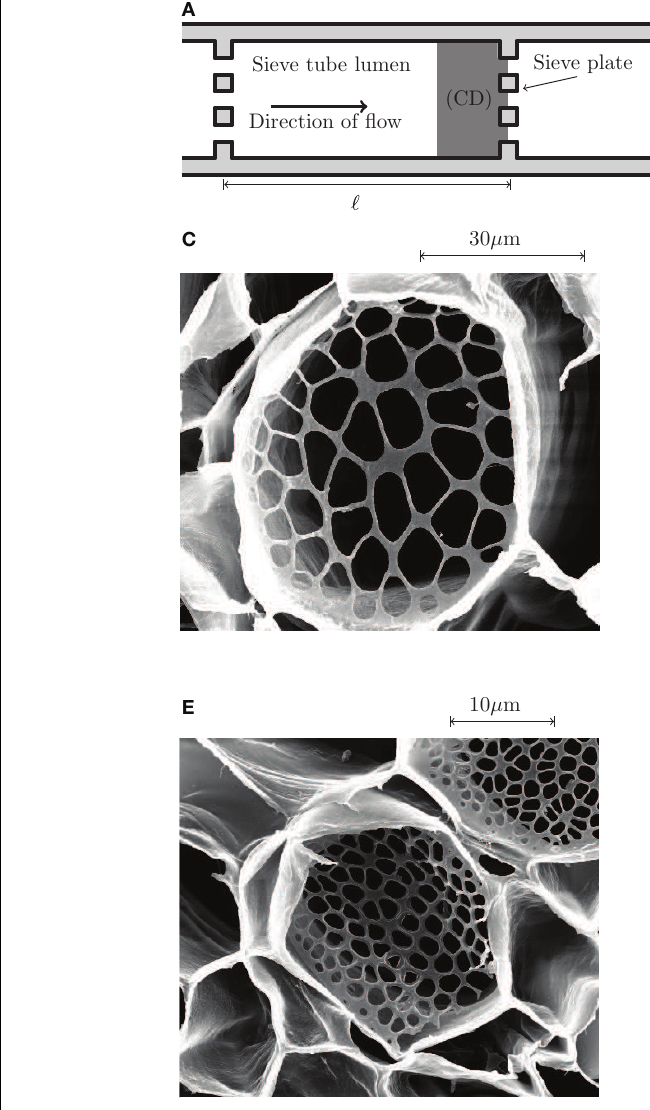
FIGURE 1 | Phloem sieve tube geometry. (A) Schematics of a sieve tube. Adjacent sieve tube cells of length (cid:96) and radius r are separated by thin sieve plates of thickness (cid:96) p perforated by small holes of radius r p known as sieve pores.The computational domain (CD) used in the numerical simulations is highlighted in dark gray. (B) Schematic end view of a sieve plate. On average, about 50% of the sieve plate area is covered by open pores. (C–F) Scanning